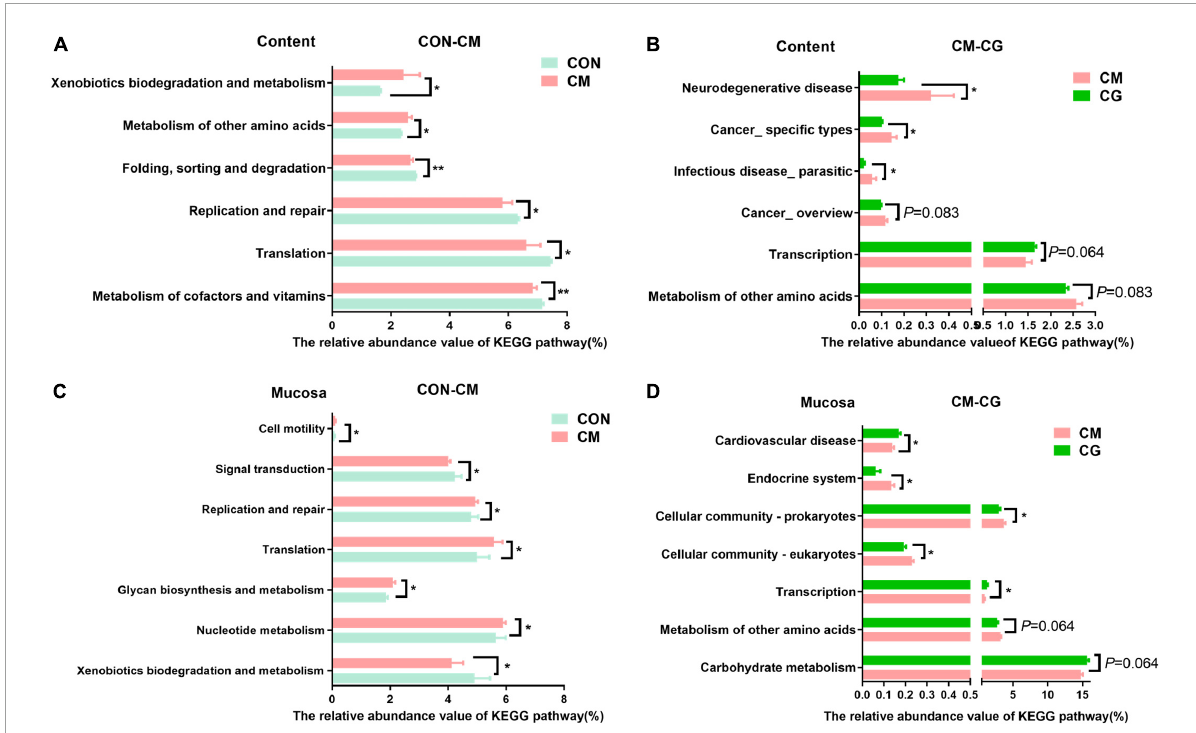
FIGURE5 Effects of low-grain fed (CON), maize meal high-grain fed (CM) and whole maize high-grain fed (CG) on the function of colonic content and mucosal bacteria. (A) Kyoto Encyclopedia of Genes and Genomes (KEGG) pathways of colonic content bacteria in the CON and CM group. (B) KECG pathways of colonic content bacteria in the CM and CG group. (C) Microbial KEGG pathway of colonic mucosal bacteria in the CON and CM group. (D) Microbial KEGG pathway of colonic mucosal bacteria in the CM and CG group. * P < 0.05 indicated that mean values were significantly difference. ** P < 0.01 indicated that mean values were greatly significantly